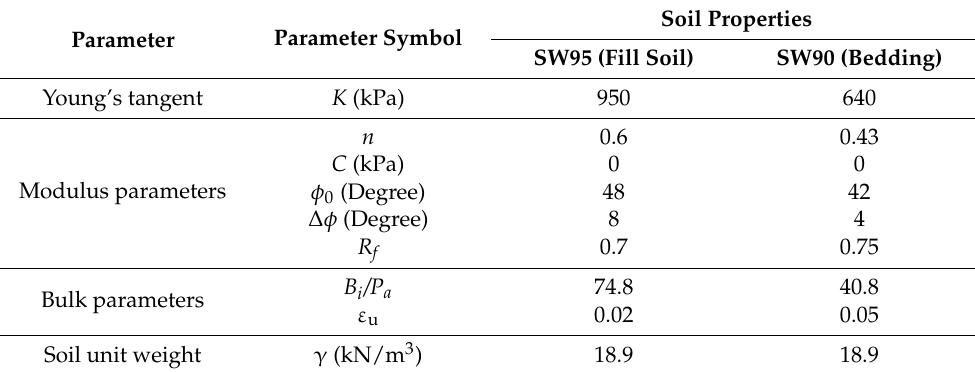
Table 3. Duncan/Selig soil parameters used in the FEA analysis.